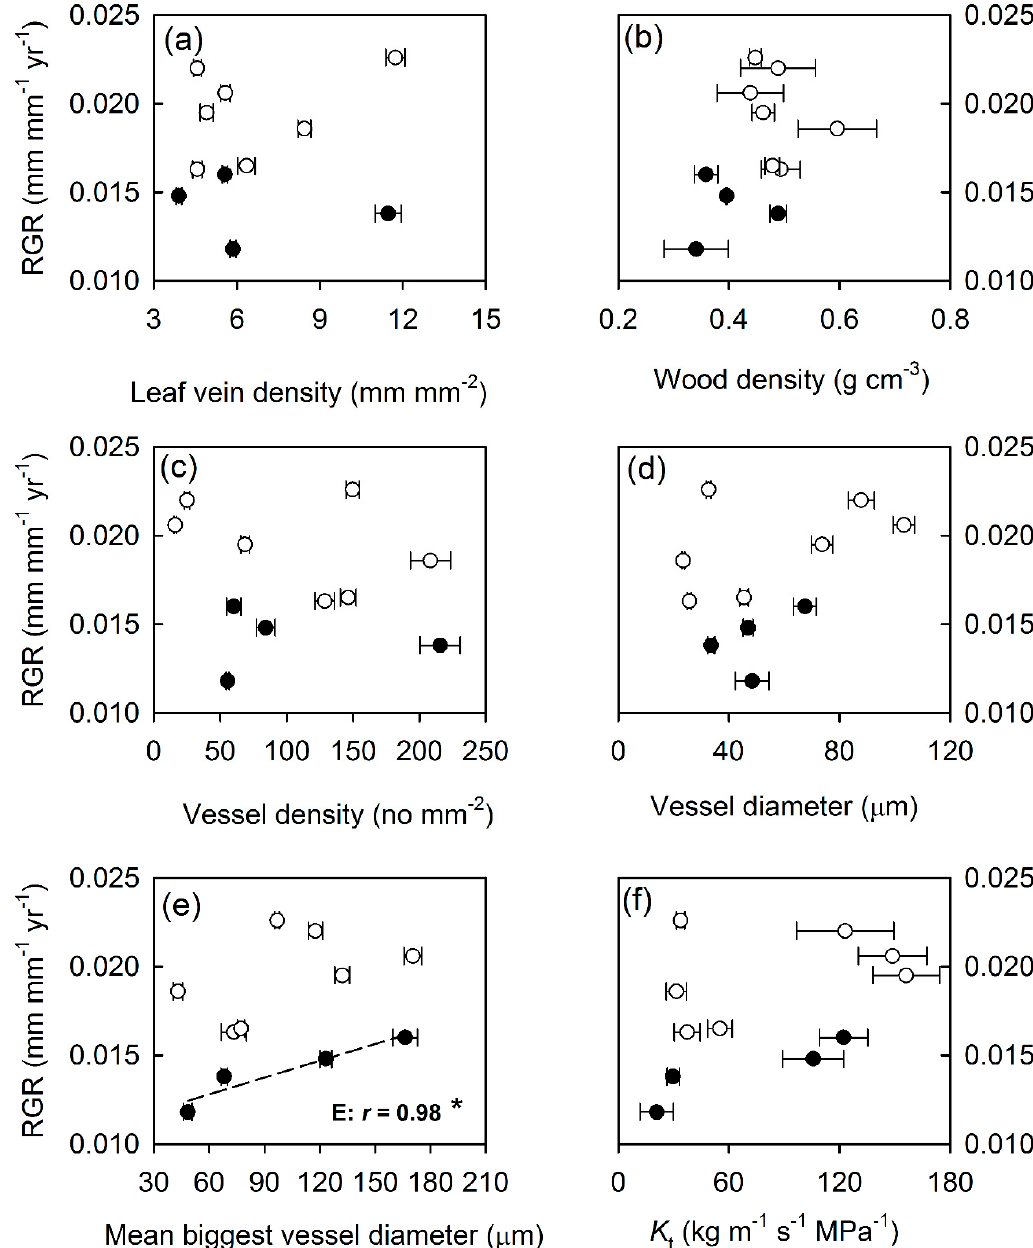
Figure 5. Relationships of relative growth rate (RGR) values with ( a ) leaf vein density, ( b ) wood density, ( c ) vessel density, ( d ) vessel diameter, ( e ) mean biggest vessel diameter, and ( f ) theoretical hydraulic conductivity ( K t ) across seven deciduous (open circle) and four evergreen (E, filled circle) lianas. Short dashed lines indicate significant correlations between RGRs and diameters of largest vessels across four evergreen liana species. The horizontal error bars indicate the standard error of leaf vein density and stem traits. Note: * p < 0.05.